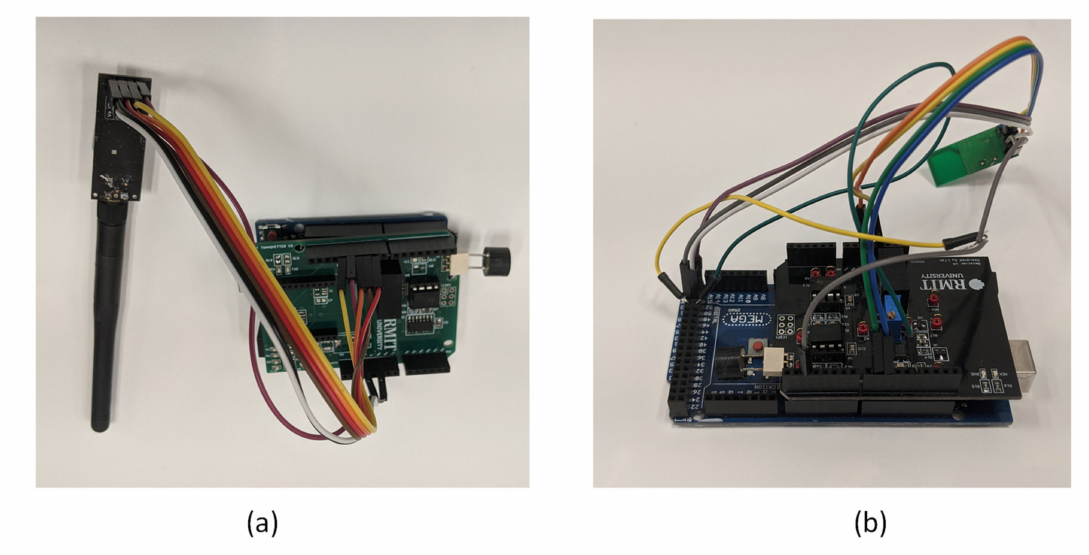
Figure 2. ( a ) Transmitter circuit. ( b ) Receiver